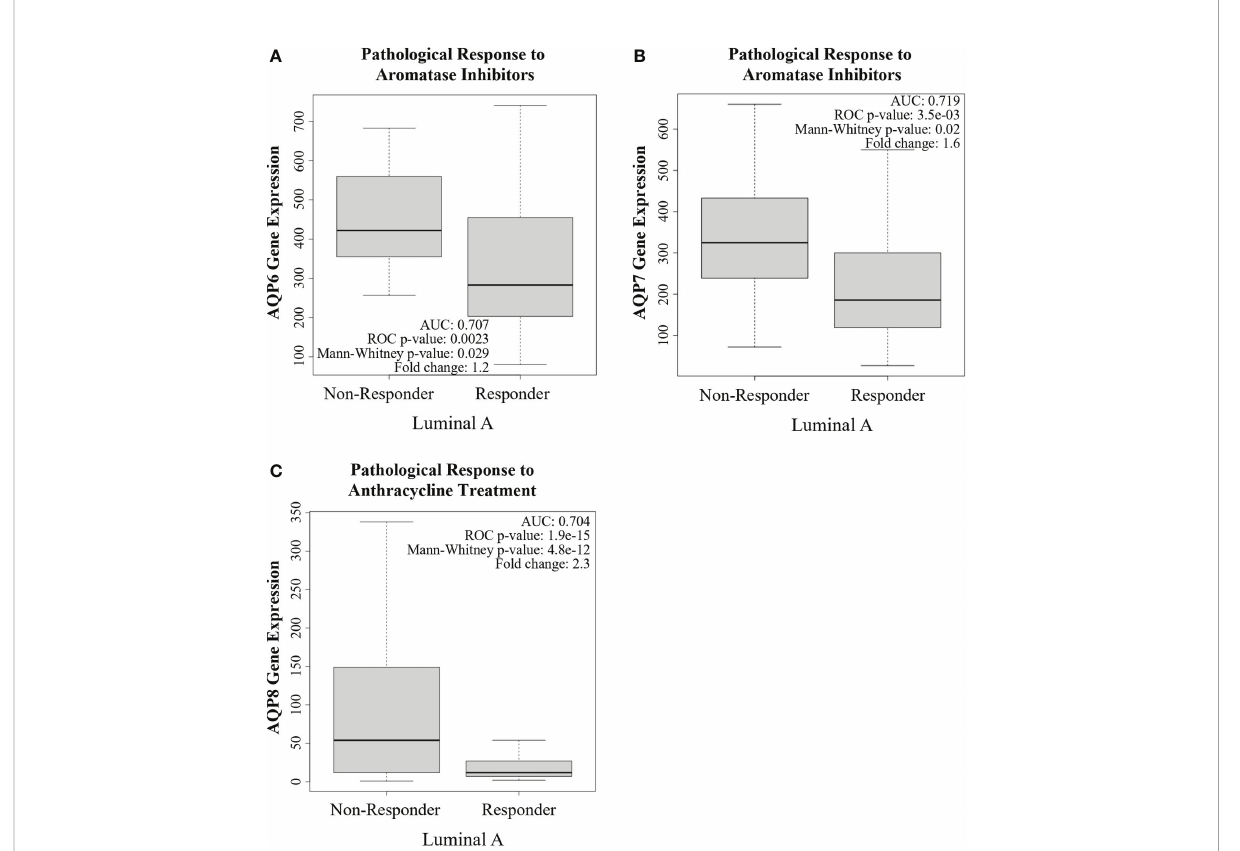
FIGURE 4 Aquaporins as a potential predictive biomarker. ROC plotter analysis of AQP6, AQP7, and AQP8 gene expression in treatment responders and non-responders, according to pathological complete response in breast cancer patients with Luminal A subtype tumors and the indicated treatments. (A) AQP6 expression was lower in responders to aromatase inhibitors than in non-responders. (B) AQP7 expression was lower in responders to aromatase inhibitors than in non-responders. (C) AQP8 expression was lower in responders to anthracycline treatment than in